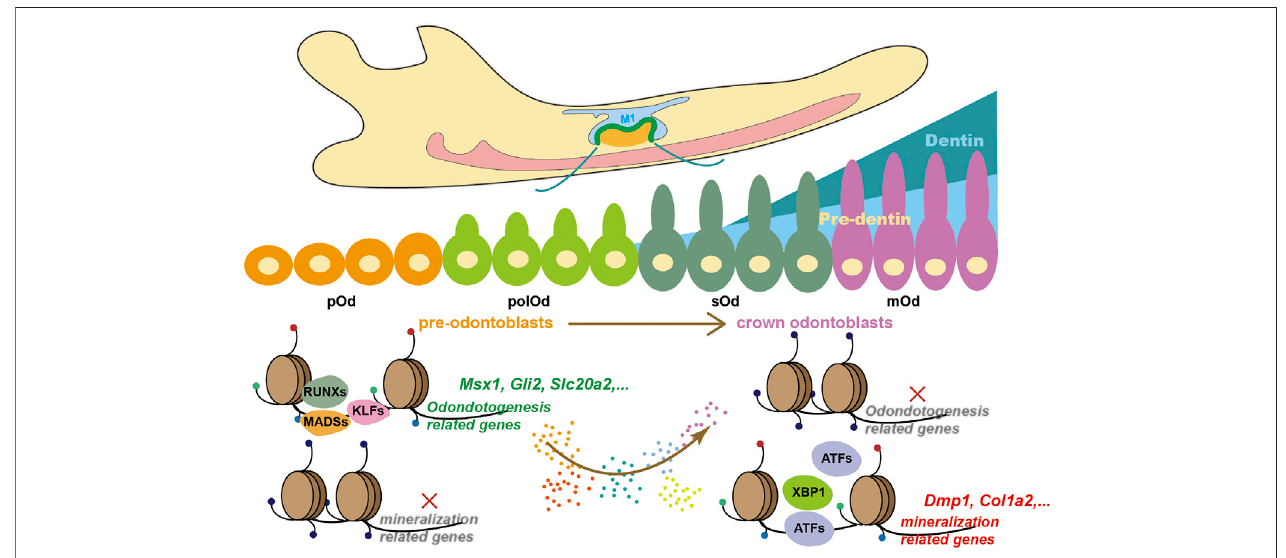
FIGURE 5 | A proposed working model describing how chromatin accessibility predetermines odontoblast terminal differentiation.